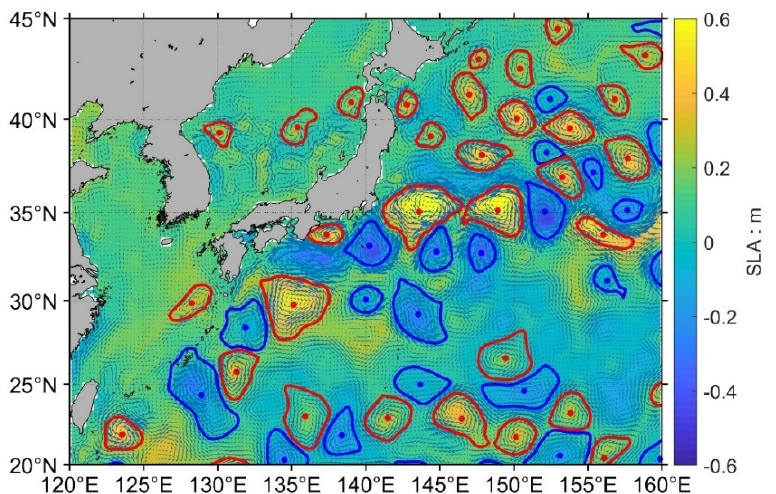
Figure 2. The distribution of Sea Level Anomaly (SLA) and the detecting results of mesoscale eddies of the western Pacific Ocean in August 2017.